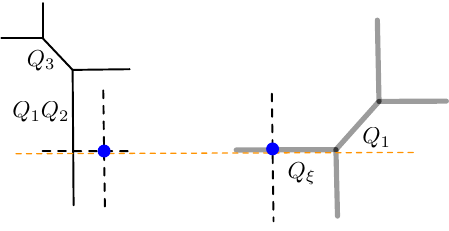
Figure 16 . Splitting the brane web ( d ) into two sub-webs. In this figure, we draw some auxiliary lines (dash lines) to let these two sub-webs look like usual 3d brane